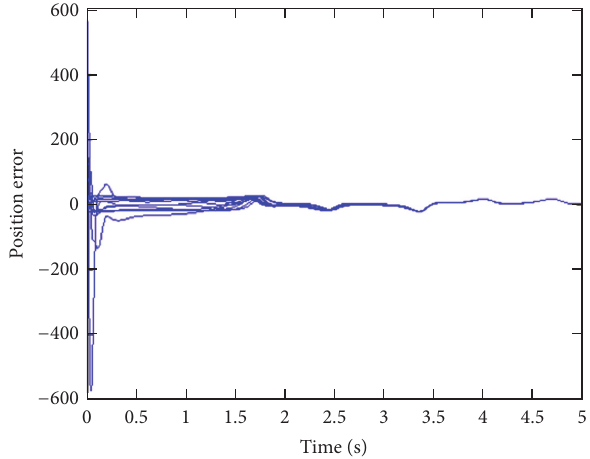
Figure 2: The inertial nodes’ position error curves.